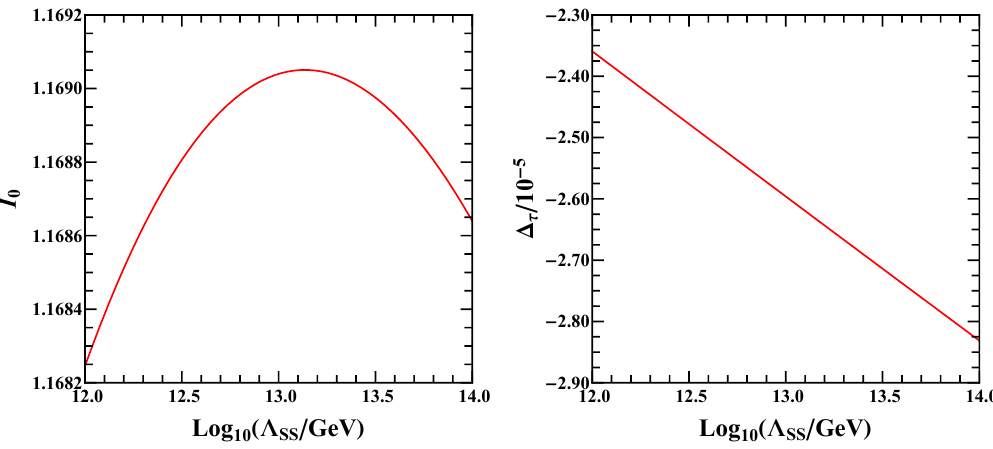
Figure 1 . The values of I and (cid:1) against the seesaw scale (cid:3) (cid:28) 0 where U and D are the PMNS neutrino mixing matrix and the diagonal neutrino mass (cid:23) matrix at low energies, respectively. Comparing eq. (2.5) with eq. (1.6), one can see that the (cid:13)avor structure of M at (cid:3) is slightly modi(cid:12)ed by nonzero (cid:1) D SS